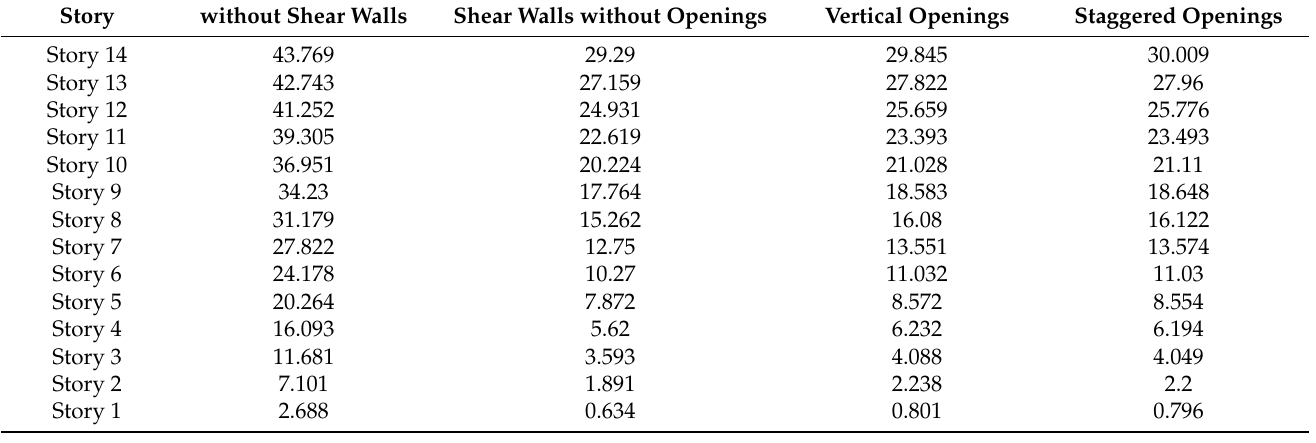
Table 7. Comparison of the story displacements, response spectrum, and Y-direction (mm).